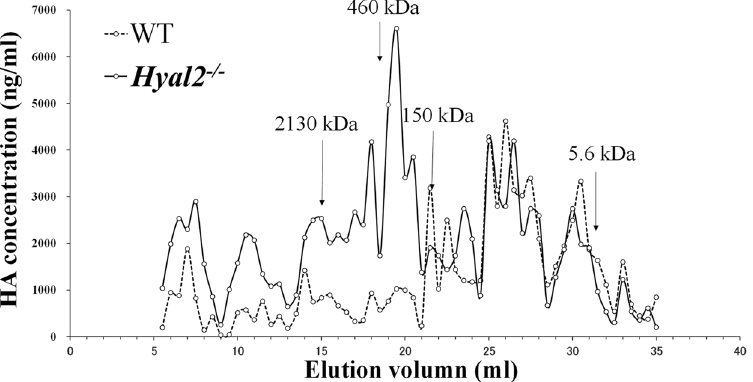
Figure 4. Hyal2 deficiency in cartilage causes the accumulation of high molecular weight hyaluronan. Hyaluronan extracted from knee joints and femoral heads of 9-month-old male mice and hyaluronan references with known molecular sizes were subjected to Sephacryl S-1000 gel filtration chromatography (0.7 × 40 cm). Hyaluronan contents in each fraction were determined using a competitive ELISA. The arrows indicate the positions of peaks of hyaluronan